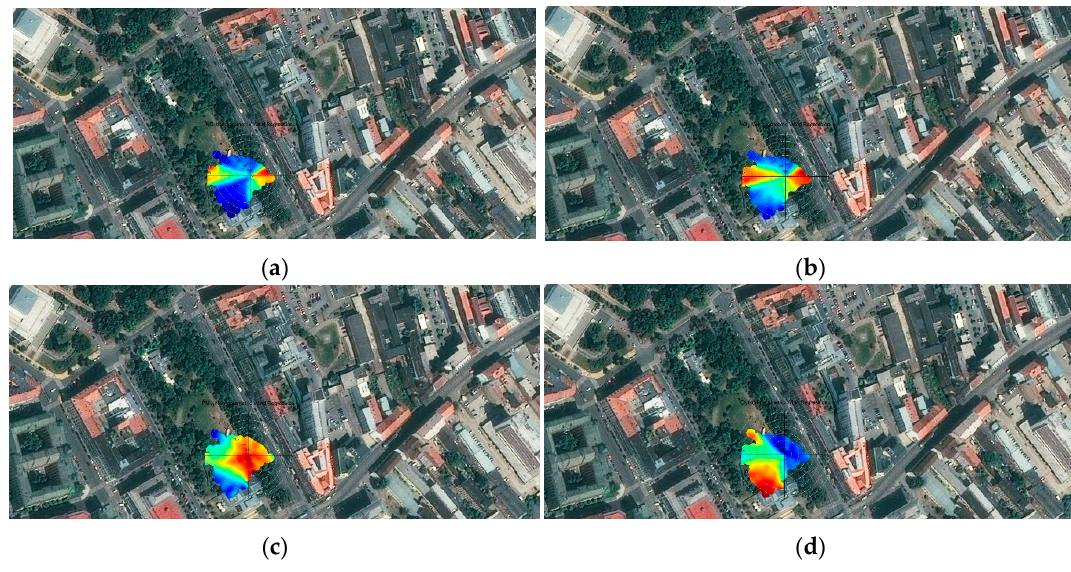
Figure 10. The NO ( a ), NO 2 ( b ), PM 10 ( c ), and O 3 ( d ) concentration relationships to the wind speed and direction at Kolišt ě ; sampling started on 7.6.2019 7:00.